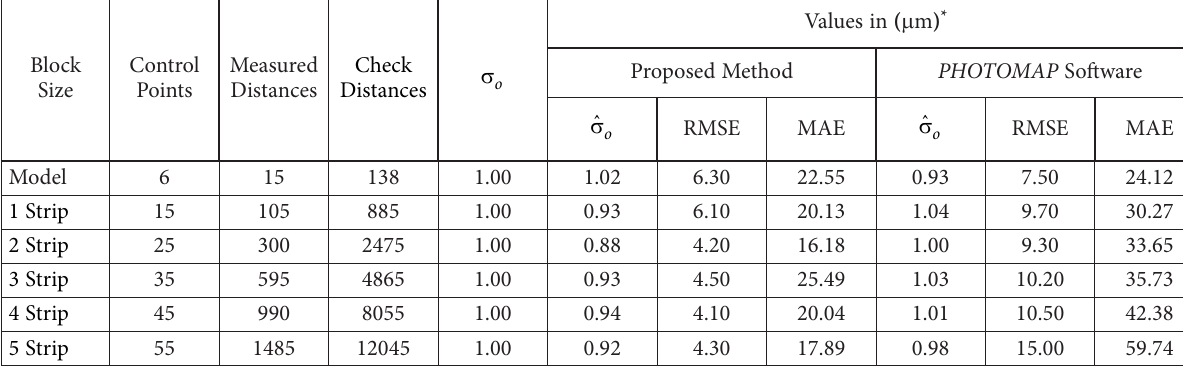
Table 3. The results of bundle block